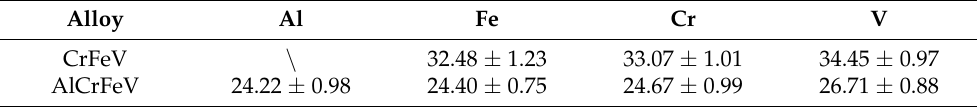
Figure 2. SEM back-scattered images and EDS-mapping of ( a ) CrFeV, and ( b ) AlCrFeV. Table 1. The measured atomic percent of elements in the CrFeV and AlCrFeV alloys (at %).